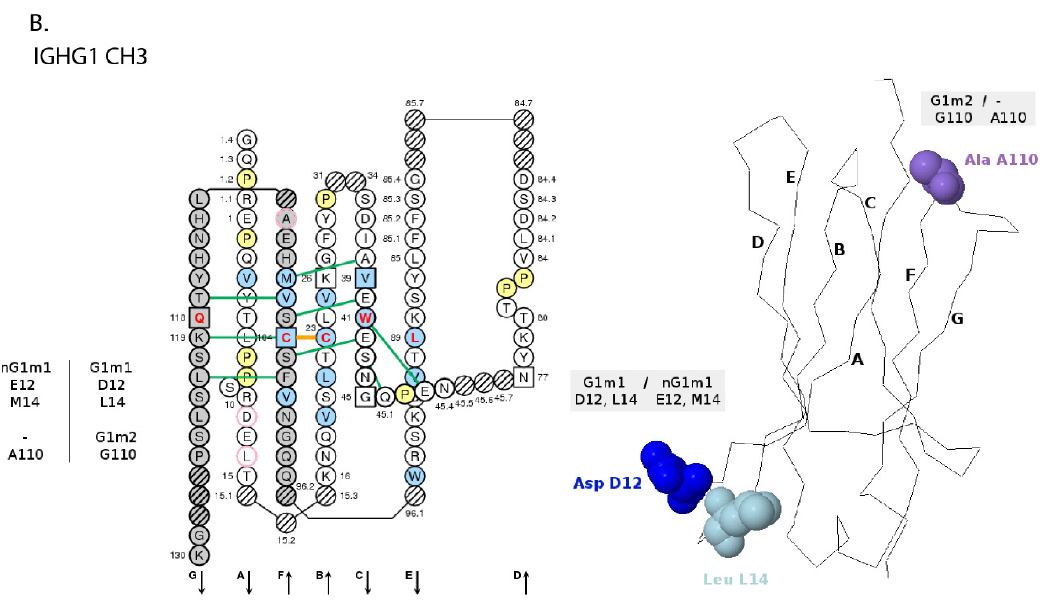
Figure 39. Homo sapiens IGHG1 and G1m allotypes [83,94]. ( A ) IGHG1 CH1. The IMGT Collier de Perles of IGHG1 CH1 on two layers is shown with hydrogen bonds, as green lines online (on the left). K120 (strand G) corresponds to the G1m17 allotype [83]. I103 (strand F) is specific of the H ‐ gamma1 chain isotype. The simultaneous presence of R120 and I103 corresponds to the expression of the G1m3 allotype (not shown) [83]. For isotypes other than H ‐ gamma1, R120 corresponds to the expression of the nG1m17 isoallotype (not shown) [83]. The 3D structure of the CH1 (on the right) shows K120 (G1m17) and the H ‐ gamma1 specific I103 [83]. ( B ) IGHG1 CH3. The IMGT Collier de Perles of IGHG1 CH3 on two layers is shown with hydrogen bonds, as green lines online (on the left). D12 and L14 (strand A) correspond to the G1m1 allotype, whereas E12 and M14 (not shown) correspond to the nG1m1 isoallotype [83]. G110 (not shown) corresponds to G1m2, whereas A110 (here) does not correspond to any allotype [83]. G129 and K130 represent the CHS in secreted IG. The 3D structure of the CH3 (on the right) shows the positions 12 and 14 of the G1m1/nG1m1 allotype, and position 110 of the G1m2/ ‐ allotype. The CH1 and CH3 domains are from the b12 antibody. The b12 H ‐ gamma1 chain is encoded by the IGHG1*01 allele and expresses the G1m17,1 allotypes, based on sequence analysis (CH1 K120, CH3 D12 and L14) [83]. The presence of an A (Ala) in CH1 121 of 1hzh_H is a PDB file error. It